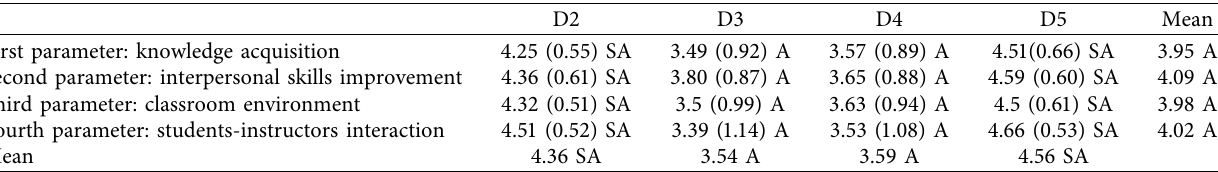
Table 5: Comparison of the mean (standard deviation) of the four parameters for D2, D3, D3, and D4 levels, according to the Likert scoring method where SA is referred to strong agree and A is referred to